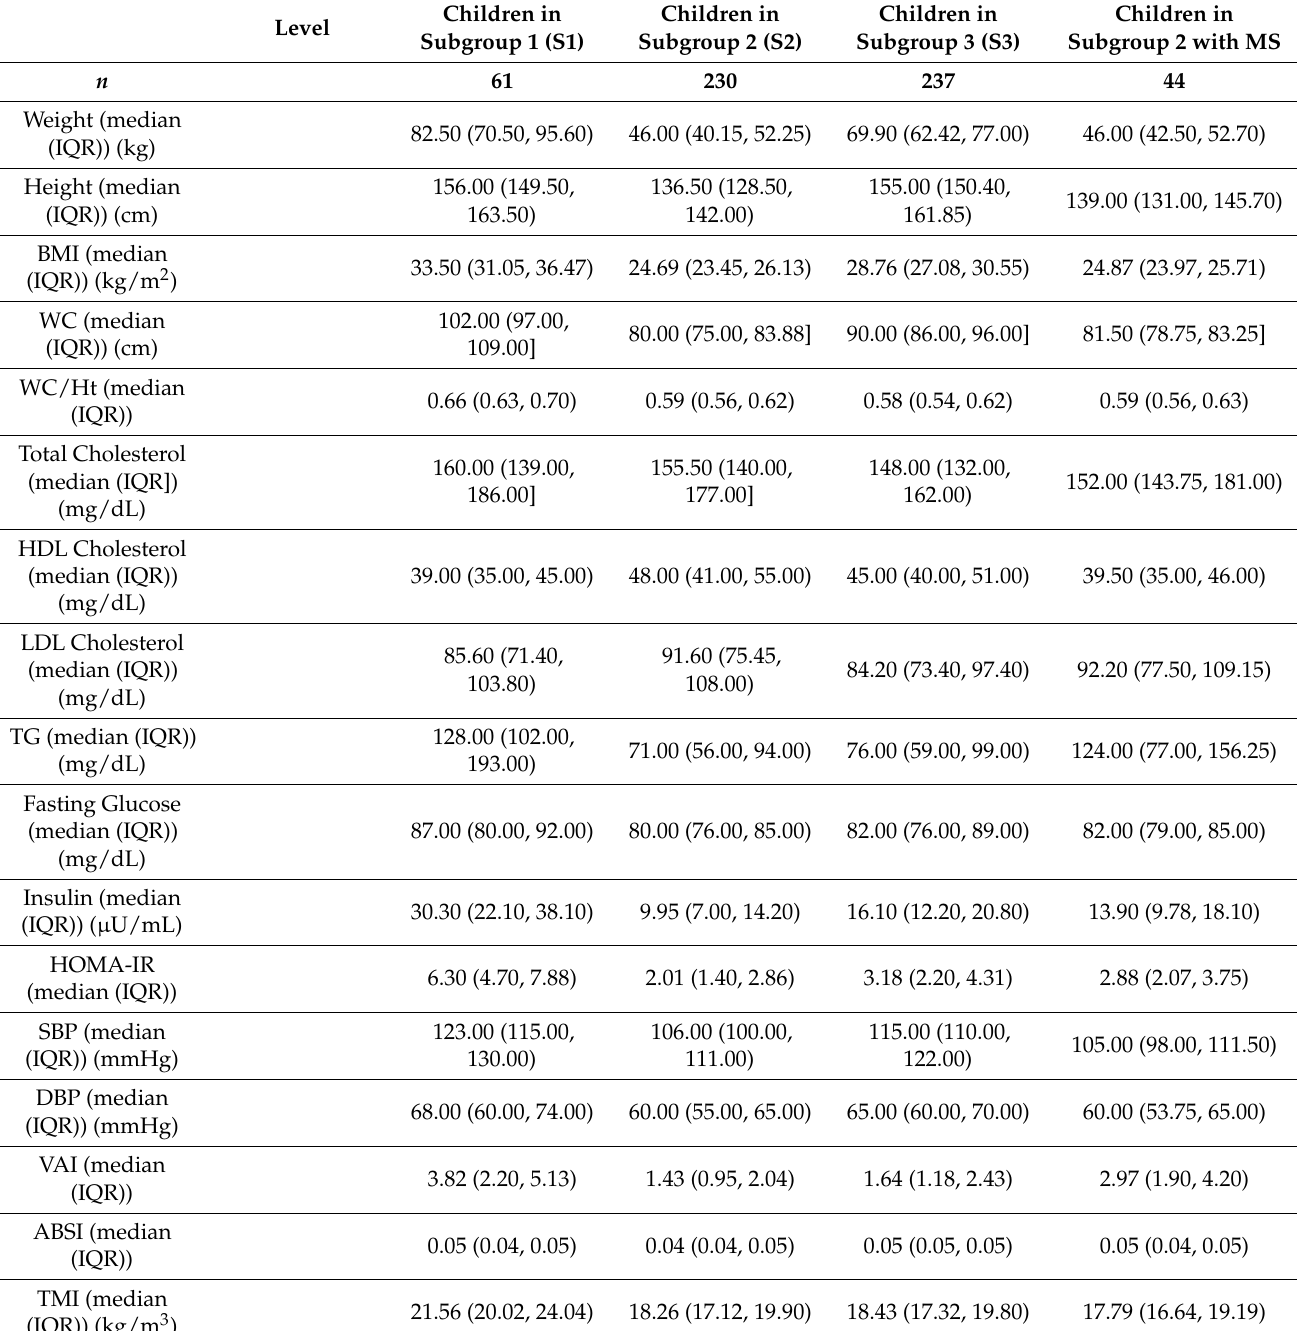
Table 2. Table 2 summarizes the descriptive statistics of the OB observations stratified by the three clusters obtained with the k-means algorithm. Here, the continuous variables are reported as the median and IQR, whereas categorical variables are reported as frequencies and percentage. S1 has the greatest prevalence of MS, followed by S3 and S2. In addition, the table reports the descriptive statistics of a particular sub-cluster of S2 children which contains observations that even though are characterized by lower values of the variables positively associated with PC1, still they are classified as having MS. In fact, they show higher values in the insulin, HOMA-IR, TyG index, VAI, and fasting TG variables compared with the median values of the S2